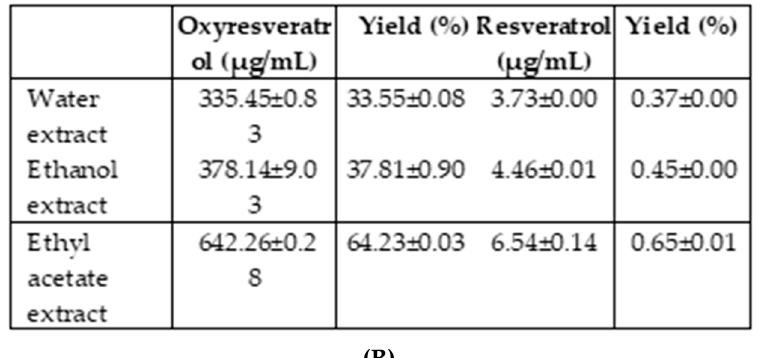
Figure 2. Chemical profiles and contents of oxyresveratrol and resveratrol in A. lakoocha heartwood extracts. ( A ) Chemical profiles of the compounds in the extracts at 250 µg/mL were analysed by HPLC at a wavelength of 320 nm; water extract, ethanol extract, ethyl acetate extract, and standard oxyresveratrol and resveratrol at 10 µg/mL. ( B ) Amount of oxyresveratrol and resveratrol detected in A. lakoocha heartwood extracts.